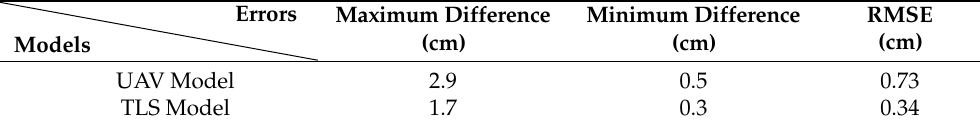
Table 4. The difference and RMSE of crack